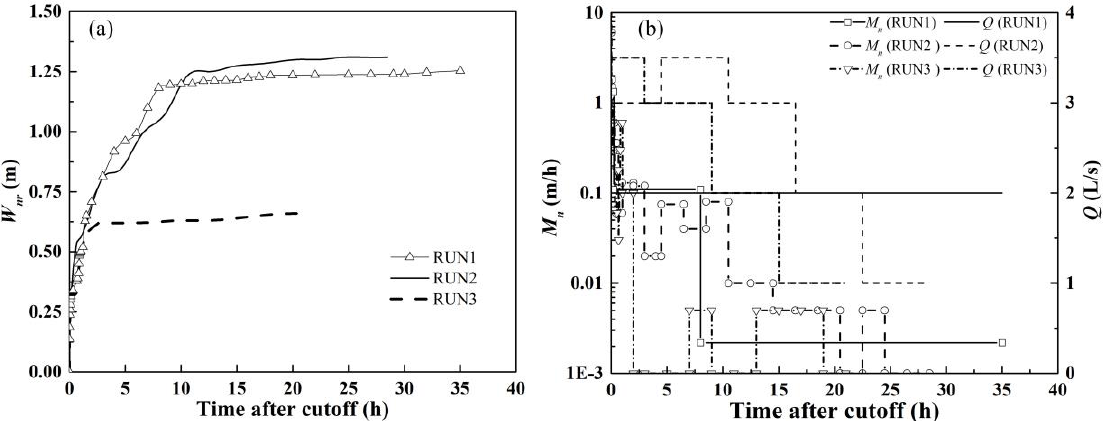
Figure 8. ( a ) Width of the new channel W nr and ( b ) the average broadening rate M n and corresponding discharge during different periods.